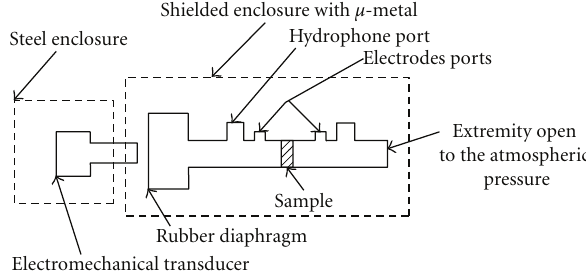
Figure 3: Experimental setup used by Thurston [87] (modified from [87]).